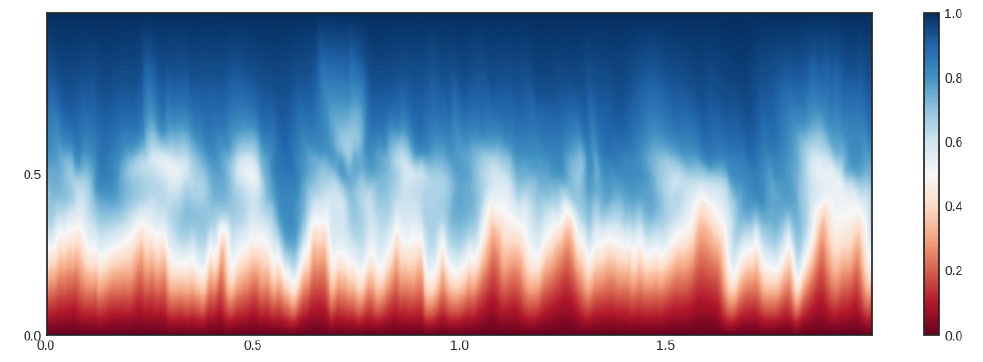
Figure 3. 2D snapshot of the temperature field along the Z-center